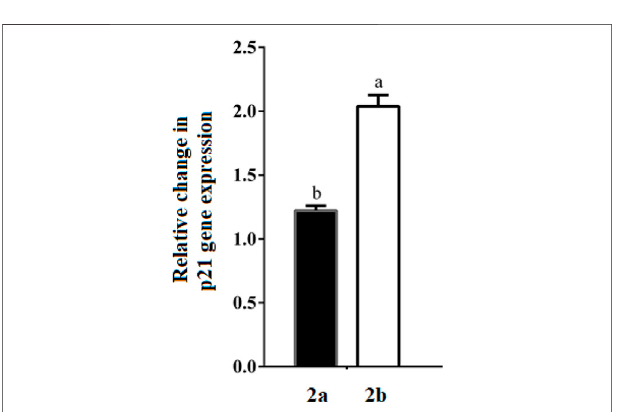
FIGURE 14 | Change in gene expression of p21 in the treated HepG-2 cells. Different letters are signi fi cantly different at p < 0.05.